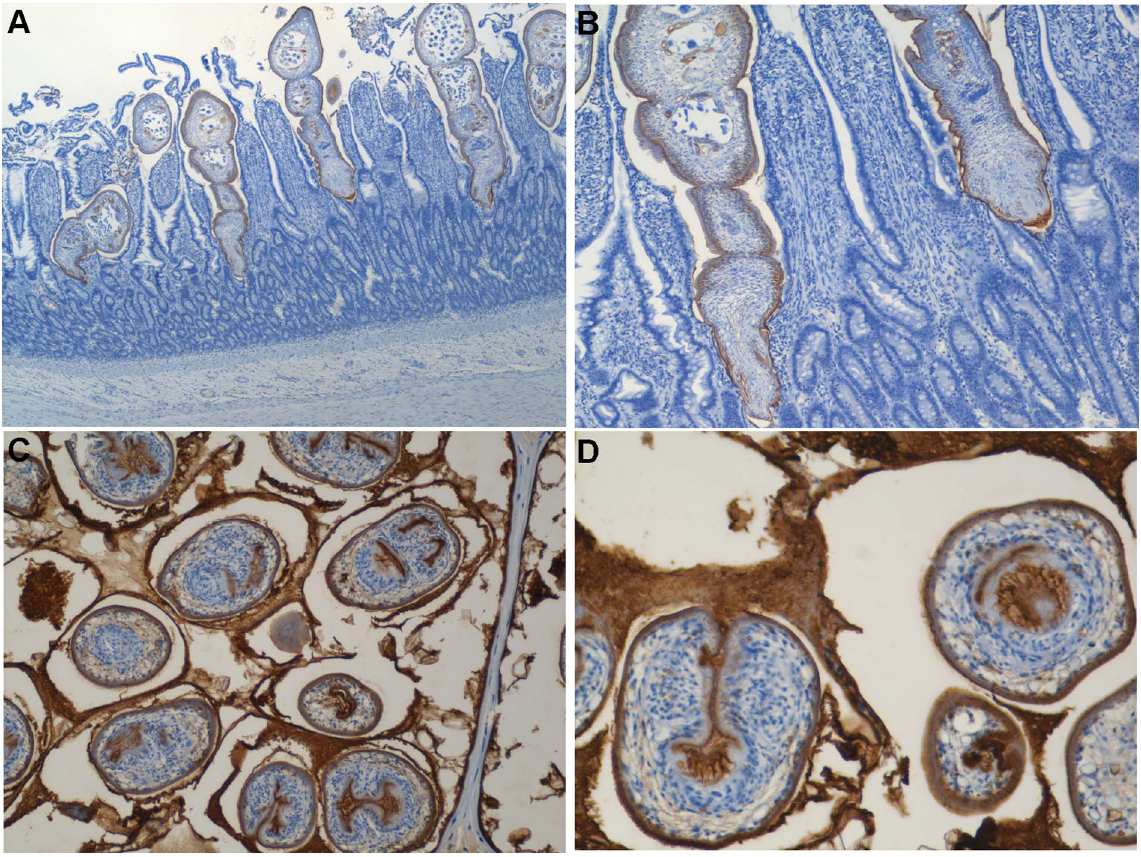
Figure 5. Localization of SRf1 in the larval and adult stages of E.multilocularis . Immunostaining was performed using polyclonal mouse anti-SRf1 antiserum. Panels A (40 6 ) and B (100 6 ) show adult worms harbored in the epithelium of the small intestine of infected dogs at 23 days postinfection. Panels C (100 6 ) and D (200 6 ) show protoscoleces in cysts derived from infected cotton rats. The brown color indicates specific antibody reactivity; the blue color indicates hematoxylin staining of nuclei. Anti-SRf1 antibodies were detected on the surface, including suckers, rostella, and hooks in both stages of worm development.